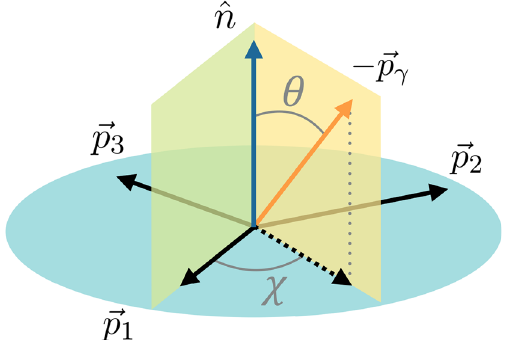
Fig. 1 Definitions of the angular variables used to describe the K ππγ system. The indices 1, 2 and 3 refer respectively to the final-state π + , π − and K + in B + → K + π − π + γ decays, and to π − , π 0 and K + in B 0 → K + π − π 0 γ